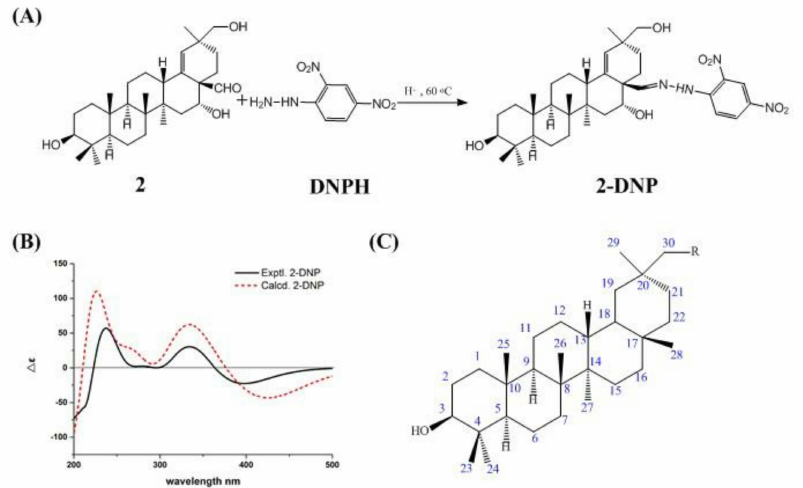
Figure 3. Mechanism of the reaction of DNPH with the aldehyde group of compound 2 ( A ). Exper- imental ECD spectra of compound 2–DNP and calculated ECD spectra of compound 2–DNP ( B